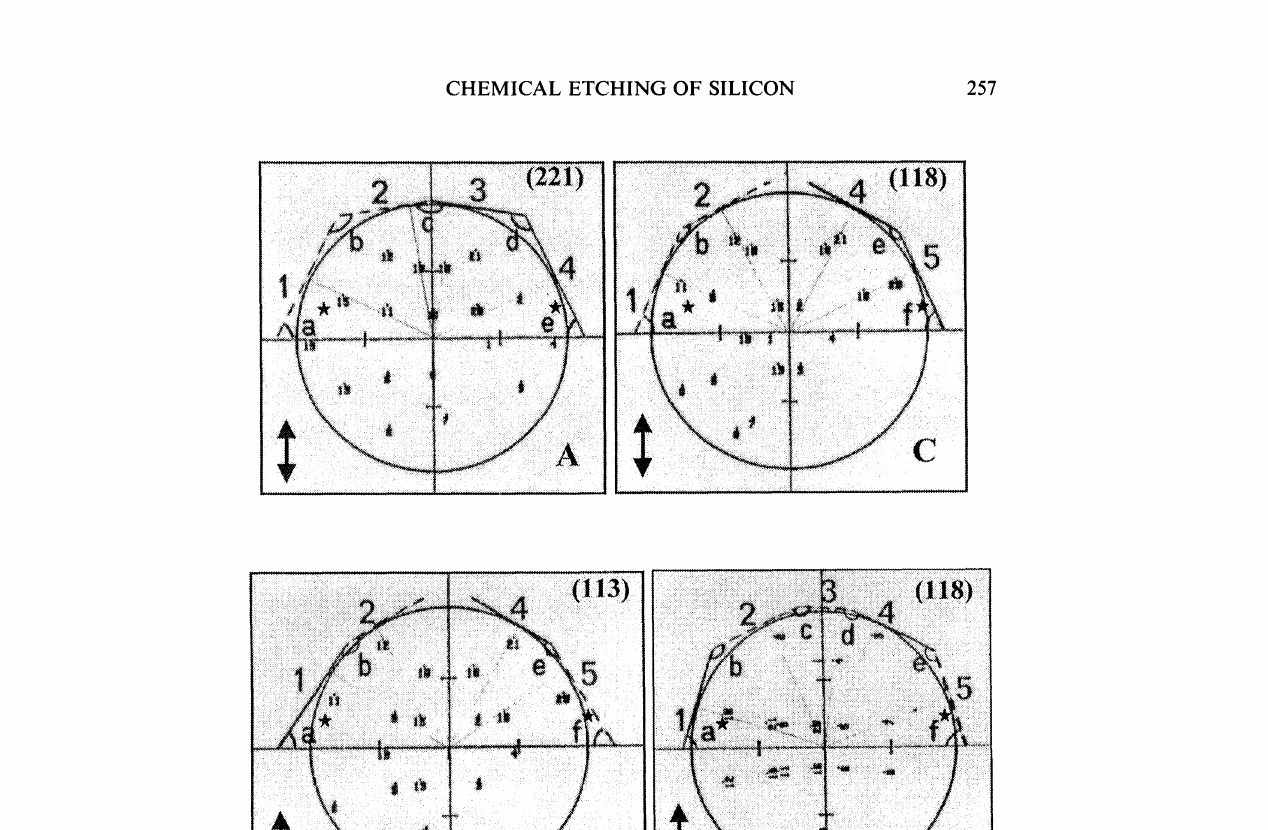
FIGURE 11 The top contour for various "circular" (h h/) or (h k 0) mesa as derived from the stereographic analysis. A, B, C and D are for (22 1), (1 3), (1 8) and (3 50) structures respectively.